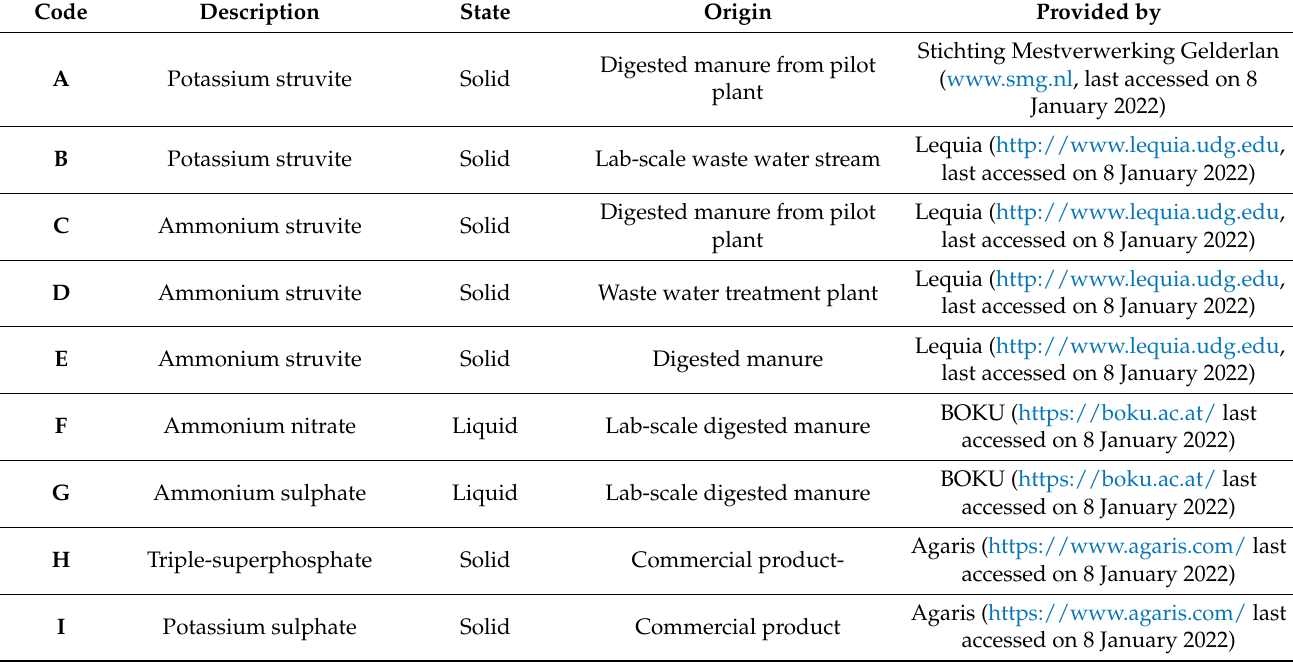
Table 1. Codification of the different recovered nutrients and fertilisers used.